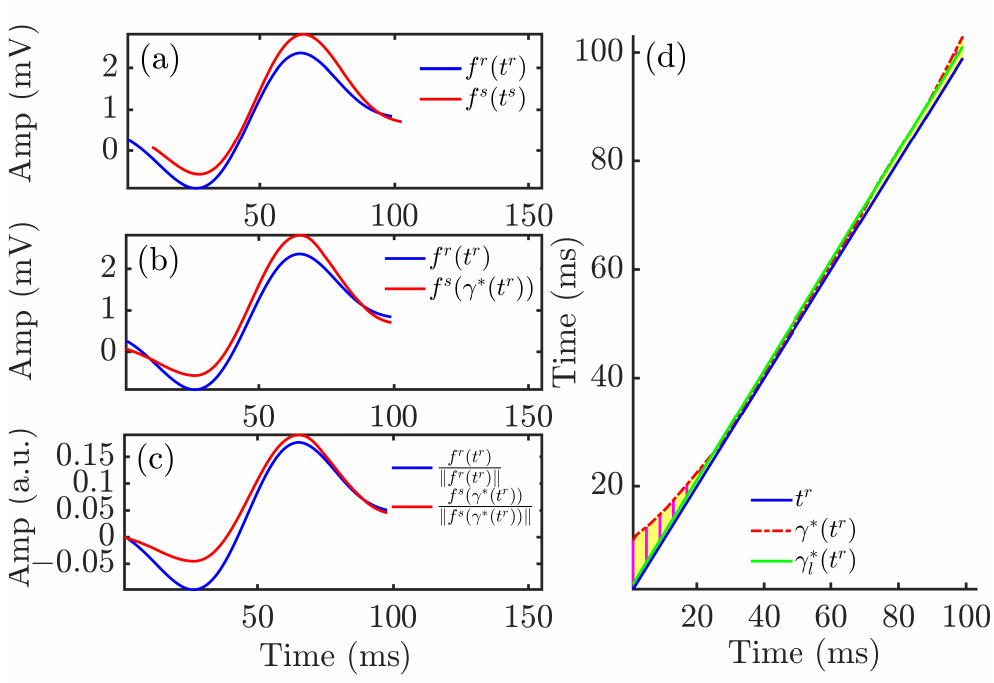
Figure 3. Time warping of QRS complexes. Panel ( a ) shows the reference (blue) and investigated (red) QRS complexes obtained from an ECG segment during HD. Panel ( b ) shows the warped QRS complexes, which had the same duration whilst keeping the original amplitude. Panel ( c ) depicts the warped QRS complexes after normalization by their L2-norms. The yellow area in panel ( d ) represents d u , which quantified the total amount of warping. The green solid line is the w,Q ( t r ) best fitted to γ ∗ ( t r ) linear regression function γ ∗ l